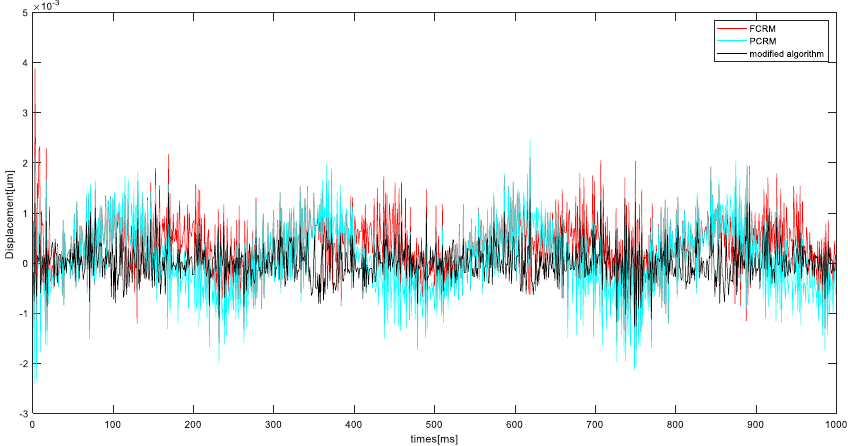
Figure 11. Error comparison of the modified model, FCRM, and PCRM when the frequency is 20 Hz.